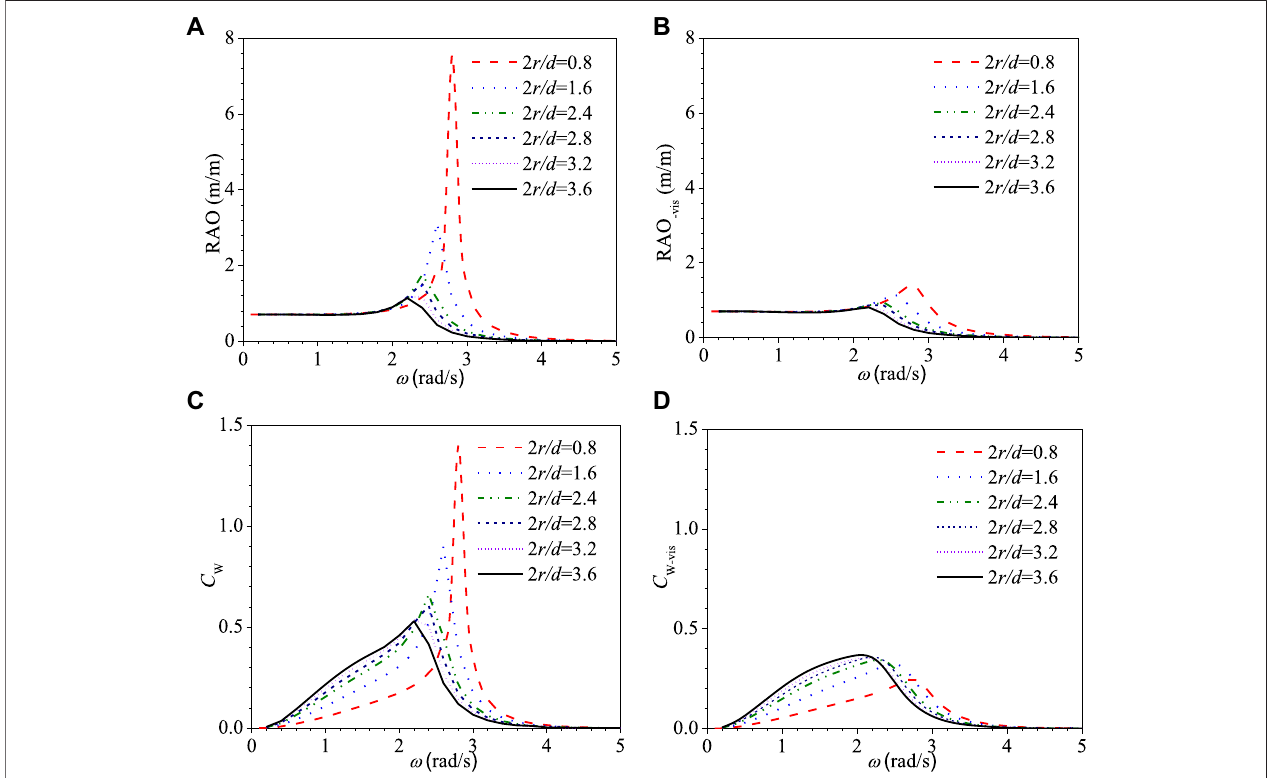
Figure 2 | Variation of heave RAO and CWR C W vs. ω for the fl at bottom cylindrical WEC with different 2 r / d . (A) RAO, (B) RAO -vis , (C) C W , and (D) C W-vis .